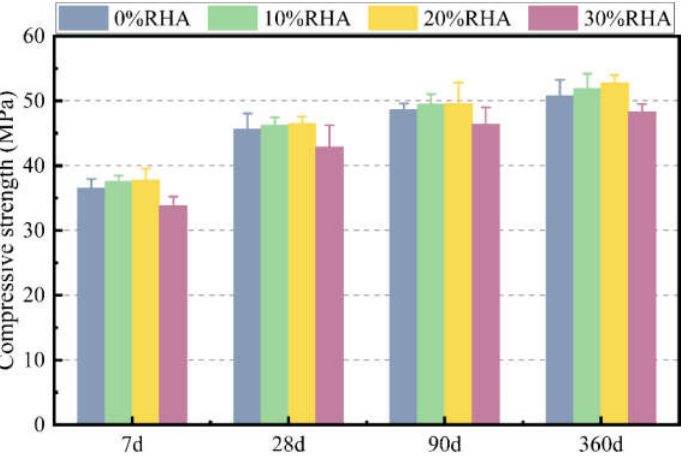
Figure 5. The impact of RHA replacement ratios on the compressive strength of recycled